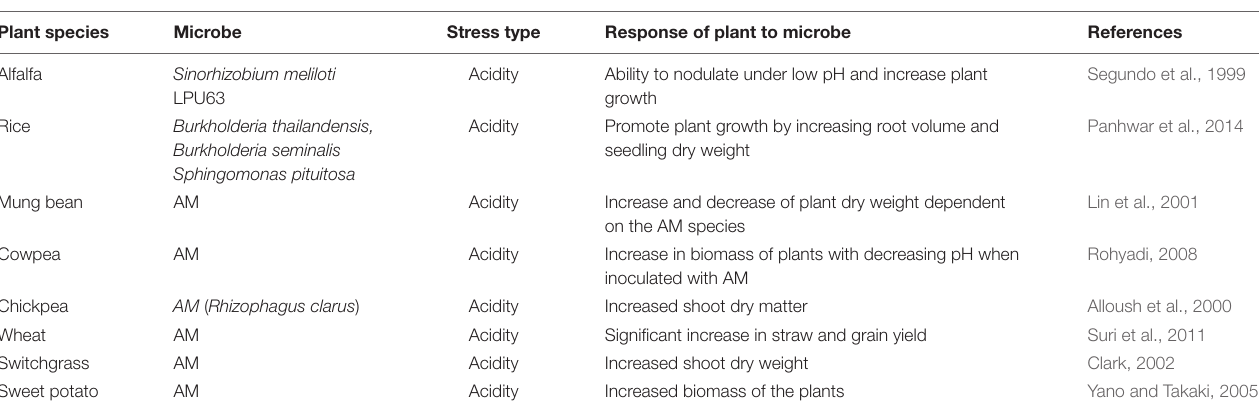
TABLE 1 | Effectiveness of PGPM on plant growth under acidity